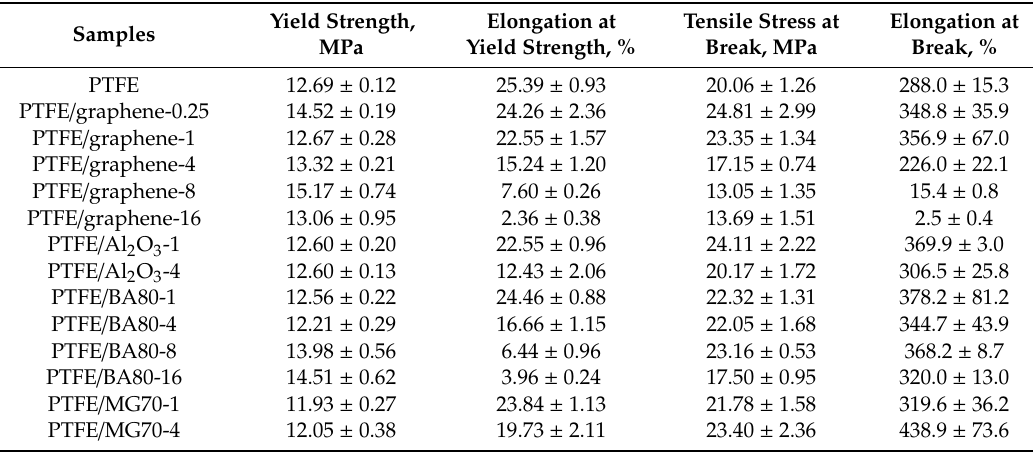
Table 8. Average Yield stress, elongation at yield strength, tensile stress at break, and elongation at break of the sintered